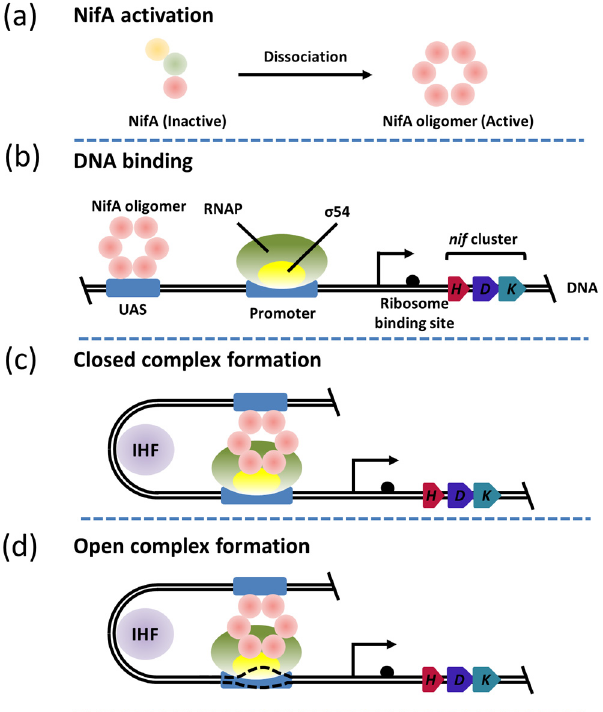
Figure 3. The transcriptional initiation process mediated by nif cluster promoted by NifA. ( a ) NifA activation. Active NifA needs to be reconstituted into an oligomeric state (predicted as hexamer). The pink ball represents NifA, and green ball represents NifL. The Glnk is represented by brown ball. ( b ) DNA binding. Oligomeric NifA can bind to the UAS region; ( c ) The formation of the closed complex. IHF can bend DNA to promote the interaction of oligomeric NifA with RNAP– σ 54; ( d ) Open complex formation. Oligomeric NifA provides energy for DNA opening promoted by RNAP– σ